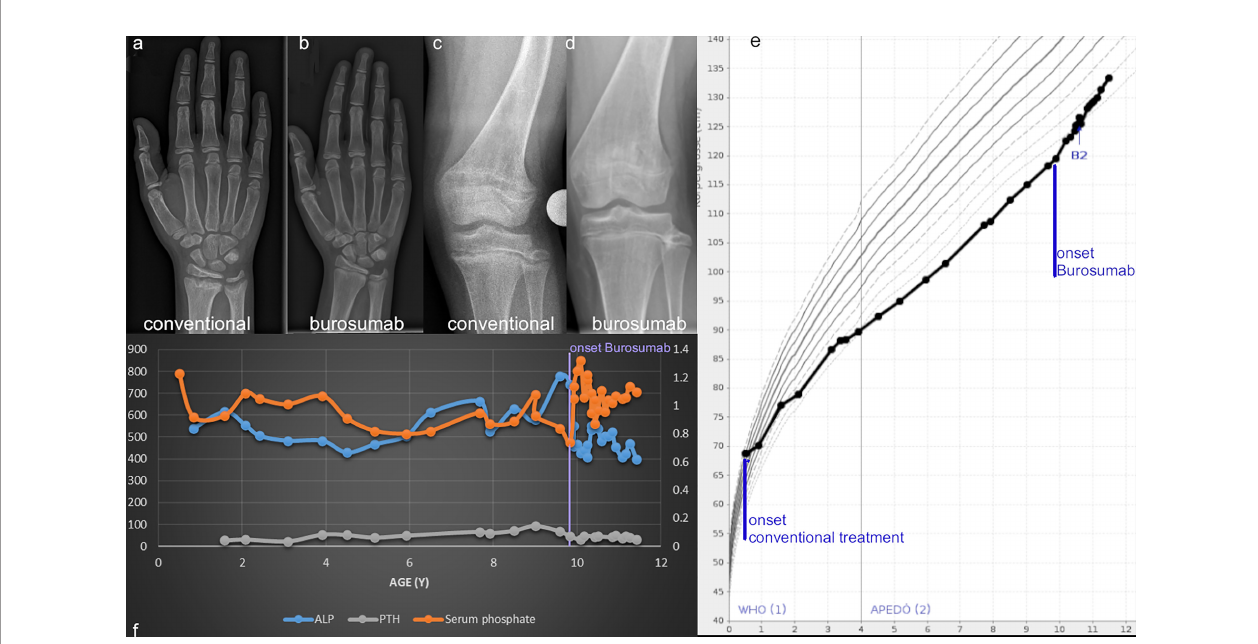
FIGURE 9 | Wrist and knee radiographs obtained before therapy onset (A, C) and at the one-year follow-up show resolution of rickets (B, D) in case 6. Linear growth, onset of treatment and thelarche (B2) are marked on the Austrian reference growth chart for girls (E) . The course of relevant biochemical parameters shows increase of serum phosphate and normalization of ALP with onset of Burosumab treatment around 10 years of age (F)